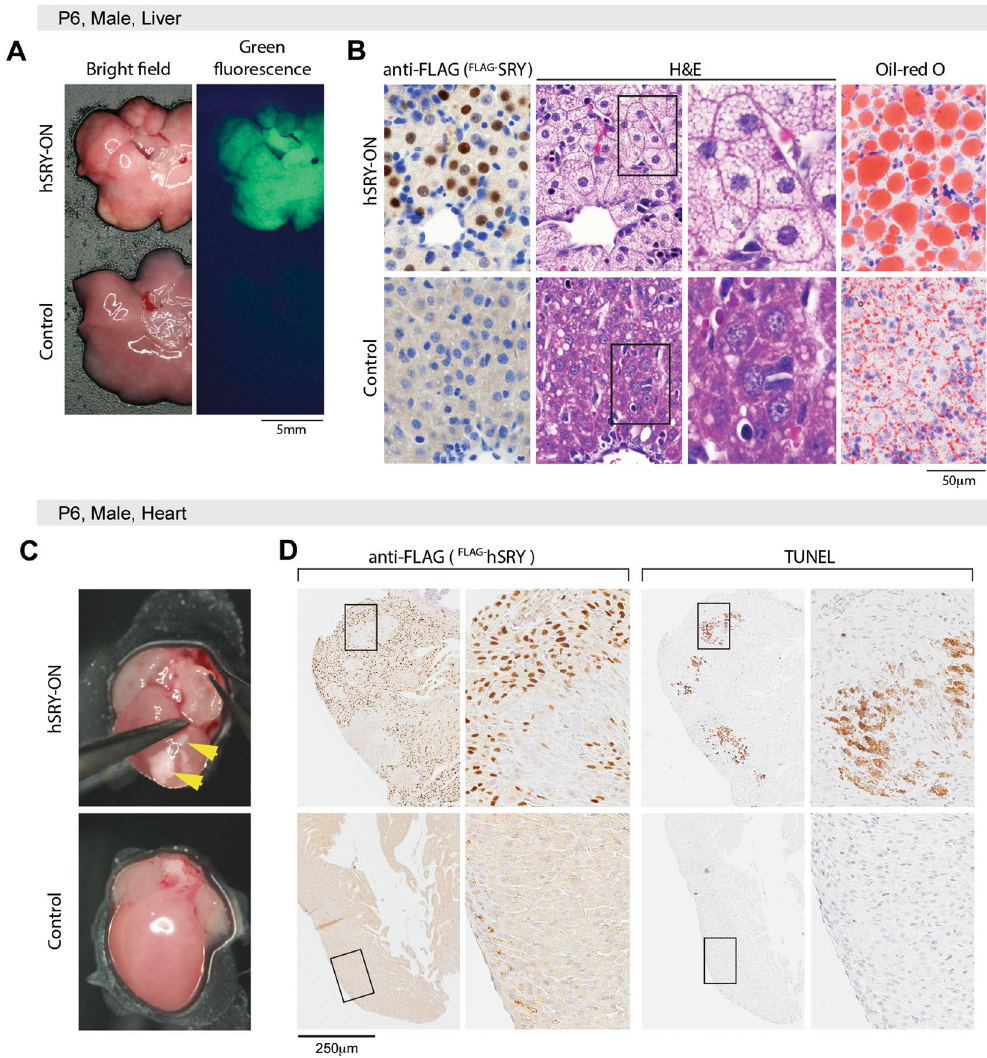
Figure 2. Abnormalities in the liver and heart of hSRY-ON mice. ( A ) Gross morphology of the liver of the hSRY-ON and control pups at P6 stage, showing discolored appearance and green fluorescence expression in a hSRY-ON mouse (top), as compared to control littermate (bottom). ( B ) immunostaining (anti-FLAG, left), H&E (middle) and Oil-red-O staining (right) of liver tissue sections of hSRY-ON (top row) and control littermate (bottom row), showing hSRY expression and hepatic steatosis/fatty liver disease phenotype in hSRY-ON animal. ( C ) White patches/spots (yellow arrowheads) in the heart of an hSRY-ON mouse at P6 age. ( D ) hSRY immunostaining (top, left) and TUNEL staining (top, right) in the heart of hSRY-ON mouse. hSRY protein was expressed in the nuclei of cardiac cells, except those at the TUNEL-positive sites. No hSRY expression or TUNEL staining in the heart of a control animal (bottom). Each boxed area represents the enlarged area in the corresponding immediate right